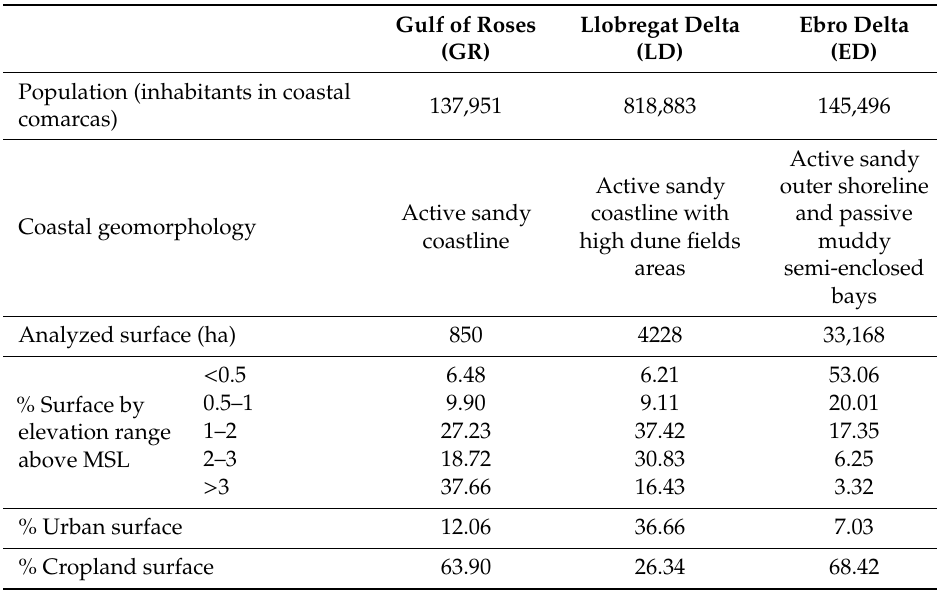
Table 1. Main characteristics of the study sites (see Figure